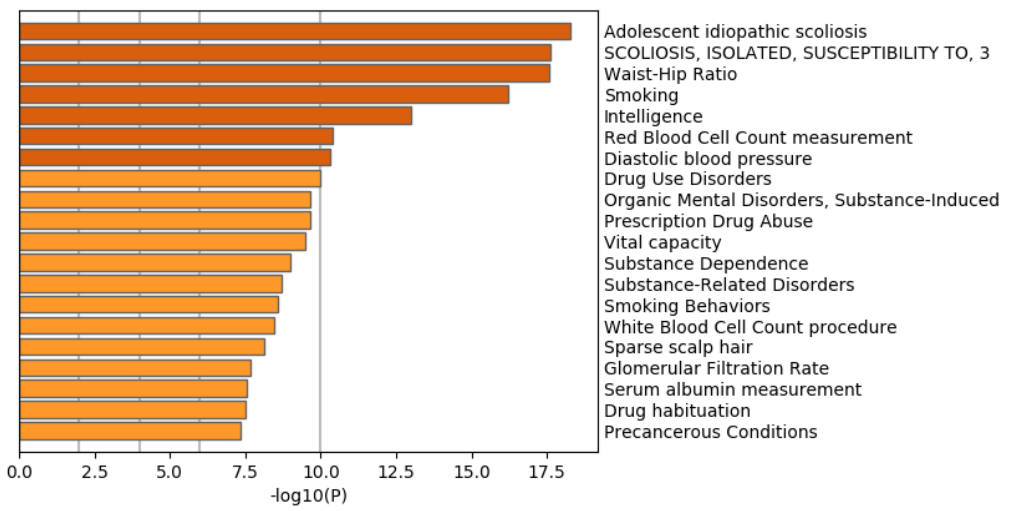
Figure 12. Summary of enrichment of the DisGeNet category of Metascape when 11,267 protein-coding genes included in 1447 genomic regions selected by RF are considered.